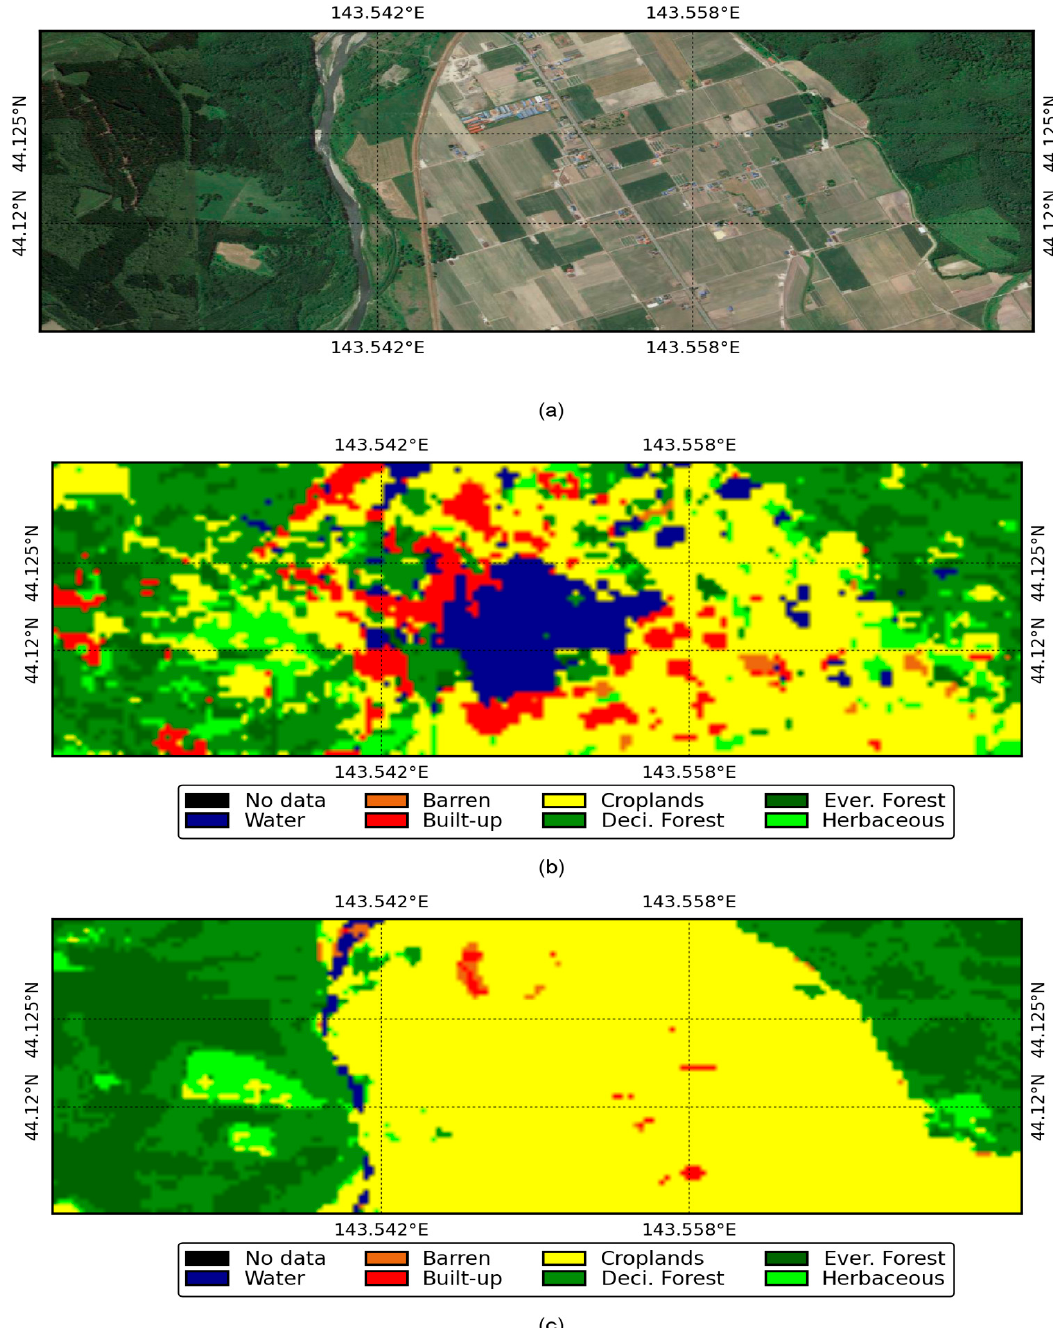
Figure 8. Performance of the JpLC-30 map over the JHR LULC map: ( a ) Google Earth™ image; ( b ) JHR LULC map; ( c ) JpLC-30 map.